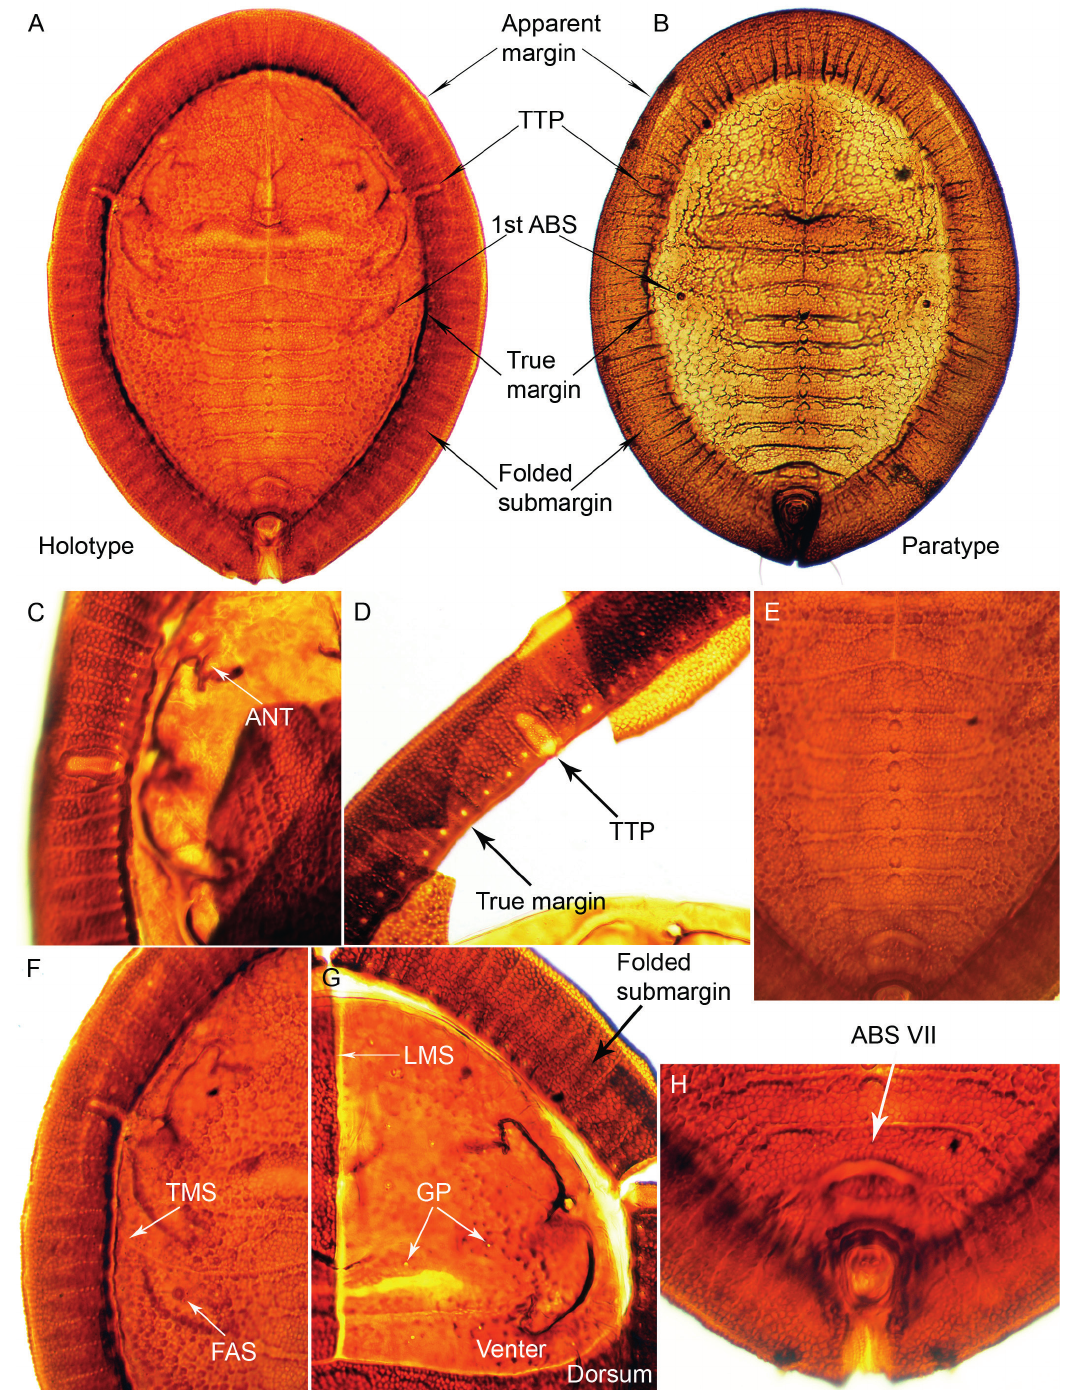
Fig. 4. Rudisculptus caudalis gen. et sp. nov., slide mounts. A . Puparium, ♀, holotype (ANRC-ZSI). B . Puparium, paratypes (ANRC-ZSI). C . Thoracic tracheal pore (PT). D . True margin. Pore (PT). E. Abdominal segments (HT). F . Moulting suture; seta (HT). G . Cephalothoracic demarcation (PT). H . Posterior abdominal area (HT). Abbreviations: ABS VII = abdominal segment VII; ANT = antenna; FAS = first abdominal setae; GP = geminate pore; HT = holotype; LMS = longitudinal moulting suture; PT = paratype; TMS = transverse moulting suture; TTP = thoracic tracheal pore; 1st ABS = first abdominal